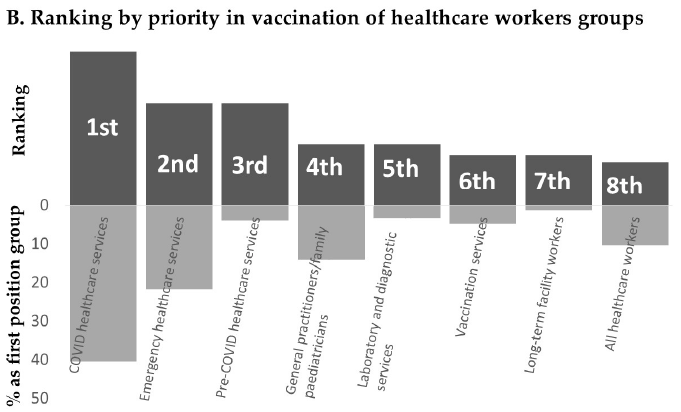
Figure 2. Ranking by priority in vaccination of population groups ( A ) and healthcare workers groups ( B ).